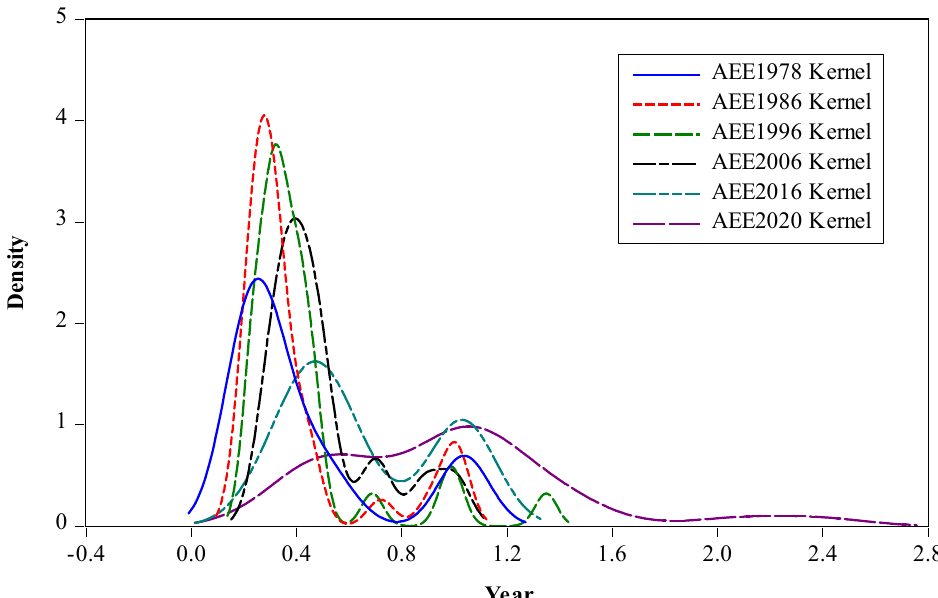
Figure 2. Kernel density estimation of AEE in China.